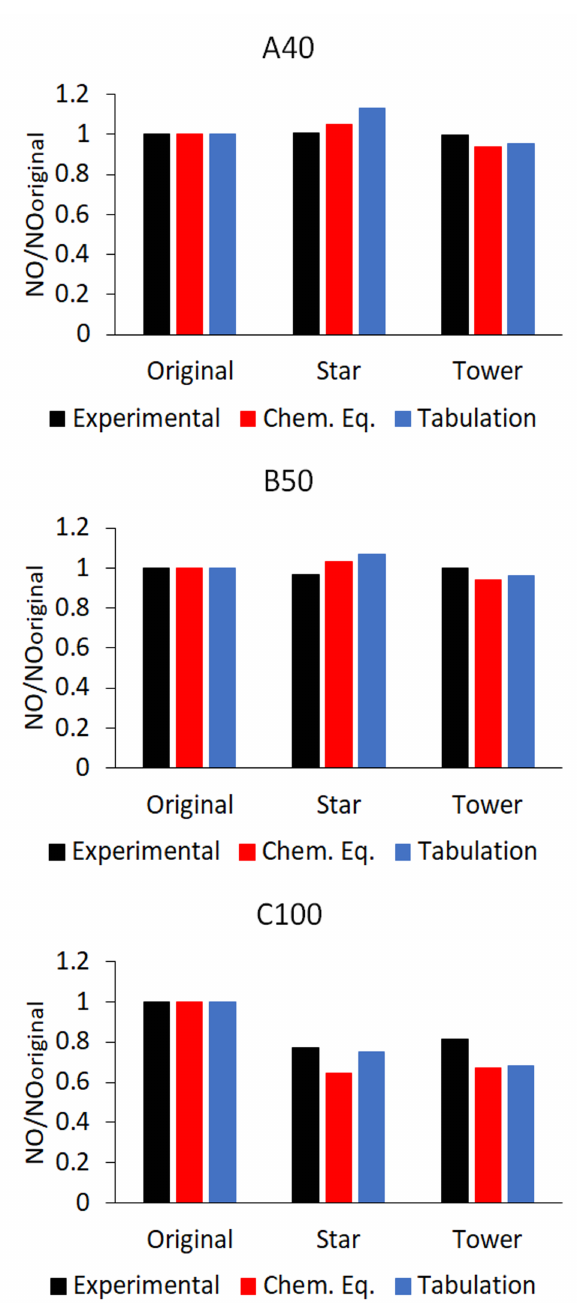
Figure 20. Comparison between computed and experimental NO emissions for the three investigated operating conditions. All values are normalized by the emissions obtained using the original